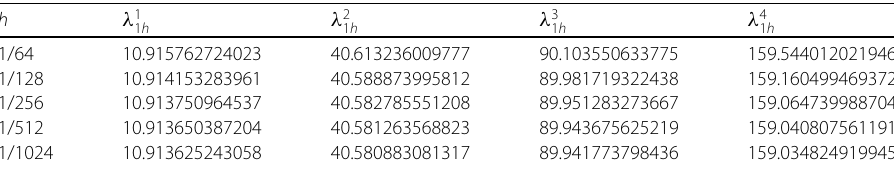
Table 8 a > 0, the four eigenvalues with l = 1 and h